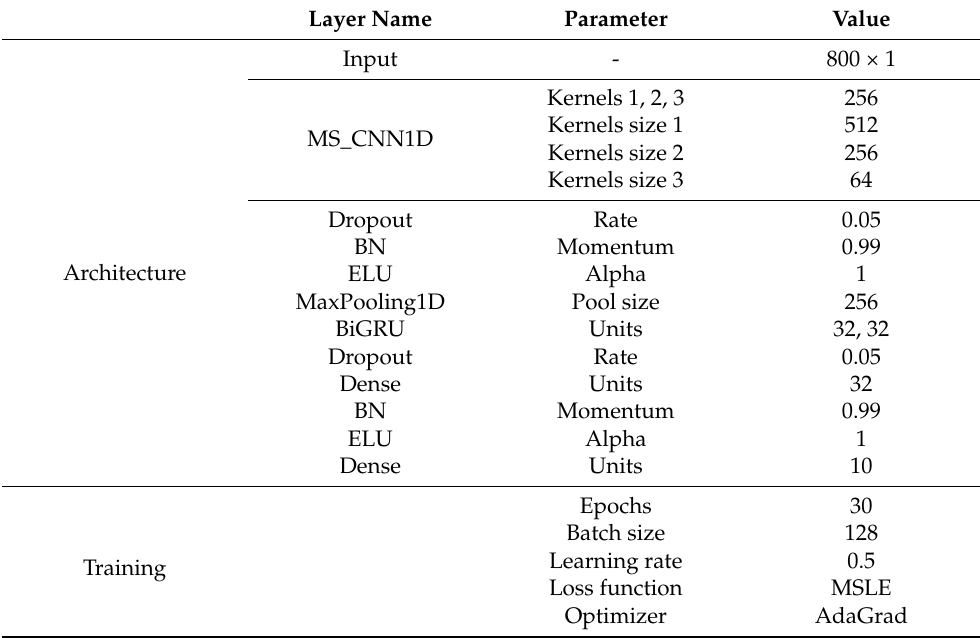
Table 1. Proposed model